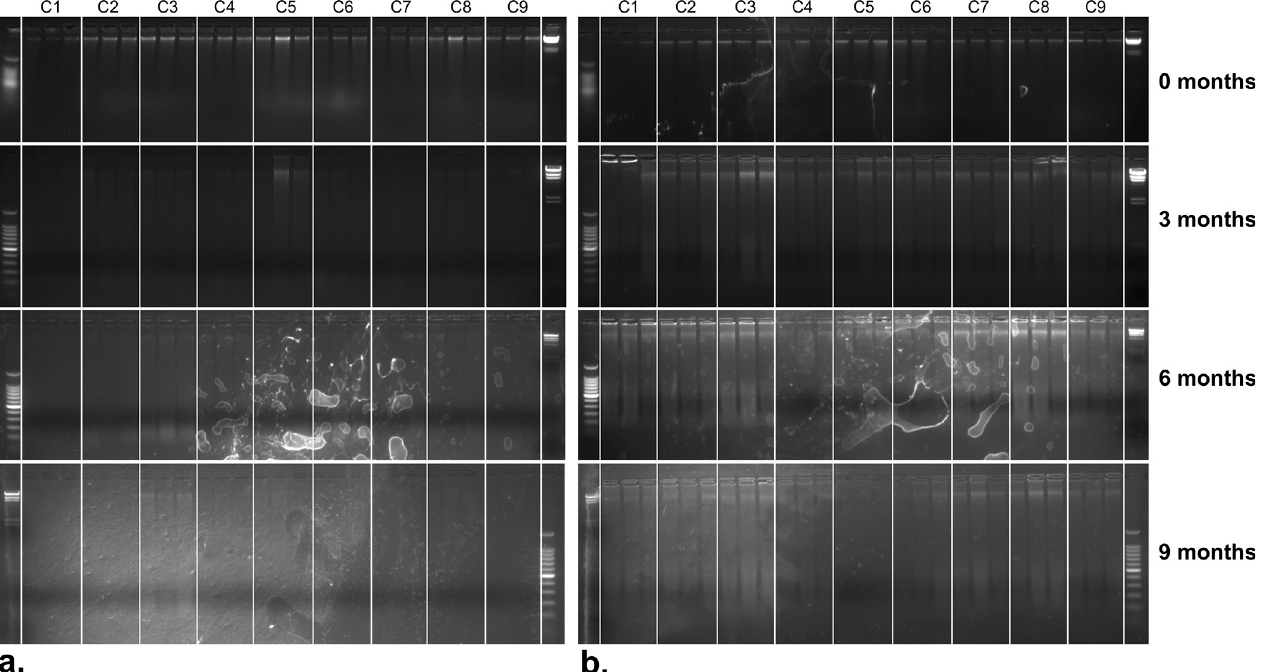
Fig 3. Electrophoretic analysis of the degradation of DNA extracted from buccal swabs and tail-hair follicles over a 9-month period. (a) 1.5% agarose gels of DNA extracted from three camel buccal swabs every three months, for a period of 9 months. (b) 1.5% agarose gels of DNA extracted from thirty camel tail- hair follicles every three months, for a period of 9 months. C1-C3: Majaheem, C4-C6: Sofor, C7-9: Waddah. Each buccal swab and tail-hair follicle quantity of each of the nine camels (C1-9) was extracted three times (replicas). The DNA in the gels is that of the first elution (E1). The two ladders used in the gels are 100 bp (left side) and lambda-HindIII molecular markers (right side). The ladders in the bottom gels are in reversed positions. Note: the six months gels contain marks but the presence and absence of large size DNA bands and smears are visible for comparison.